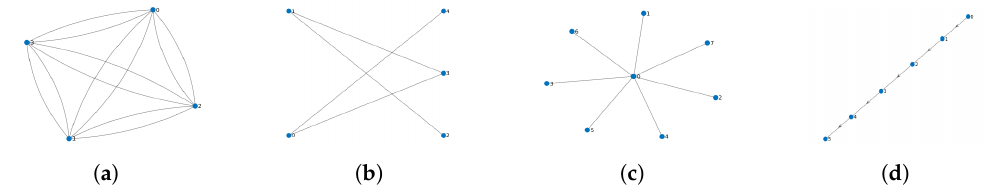
Figure 3. General graph structures relevant to RA methods. ( a ) Complete graph. ( b ) Bipartite graph. ( c ) Star graph. ( d ) Path